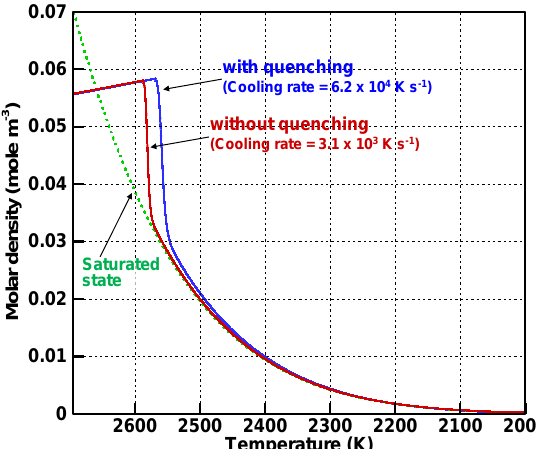
Figure 6. Evolutions of molar densities of vapor atoms and saturated states.